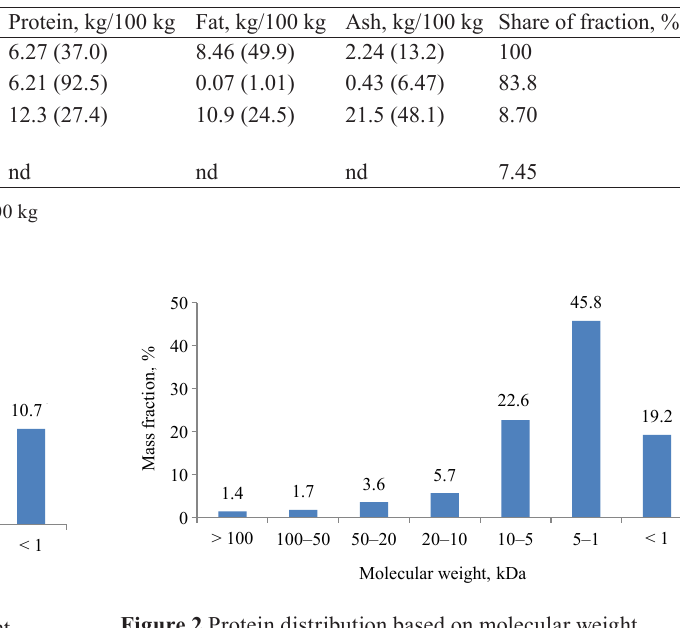
Figure 1 Protein distribution based on molecular weight of peptides and their share in protein hydrolysates from АS i sockeye heads after thermal hydrolysis